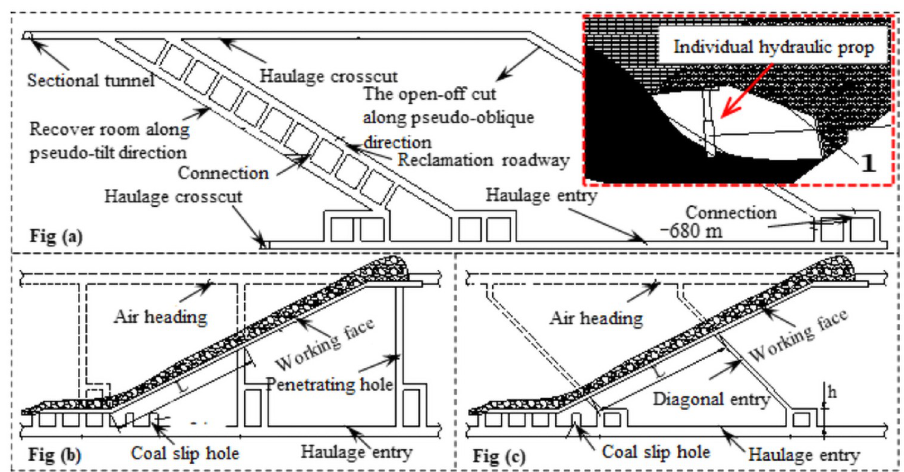
Fig 12. The schematic diagram of the working face layout. Fig (a). The open-off cut and recover rooms are all arranged along the pseudo-oblique direction. Fig (b). The coal-sliding hole was arranged in the working face. Fig (c). The pseudo-inclined roadway was arranged in the working